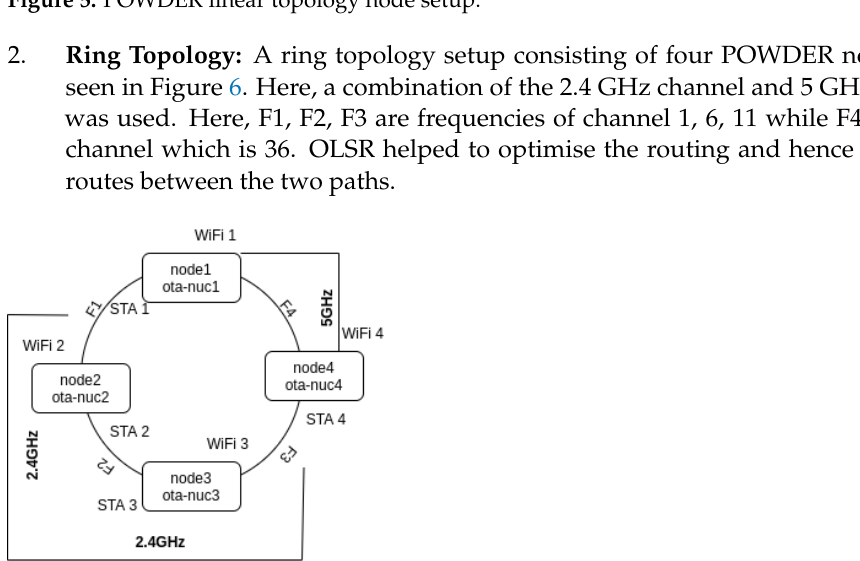
Figure 5. POWDER linear topology node setup.